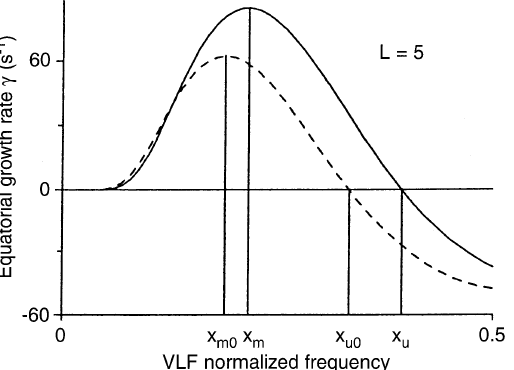
Fig. 2. Undisturbed ( dashed curve ) and disturbed ( solid ) VLF growth rate in the equatorial plane against normalized VLF fre- quency x " (cid:117) / (cid:88) (cid:101) , where (cid:117) and (cid:88) (cid:37) , are the VLF-wave frequency and electron gyrofrequency, respectively. Frequency of maximum Figure 3 (left panel) exhibits calculation results of x